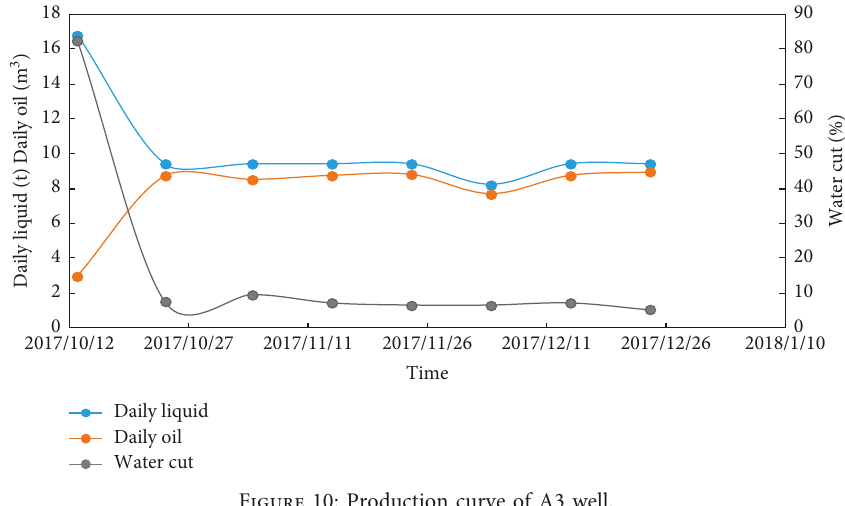
Figure 10: Production curve of A3 well.